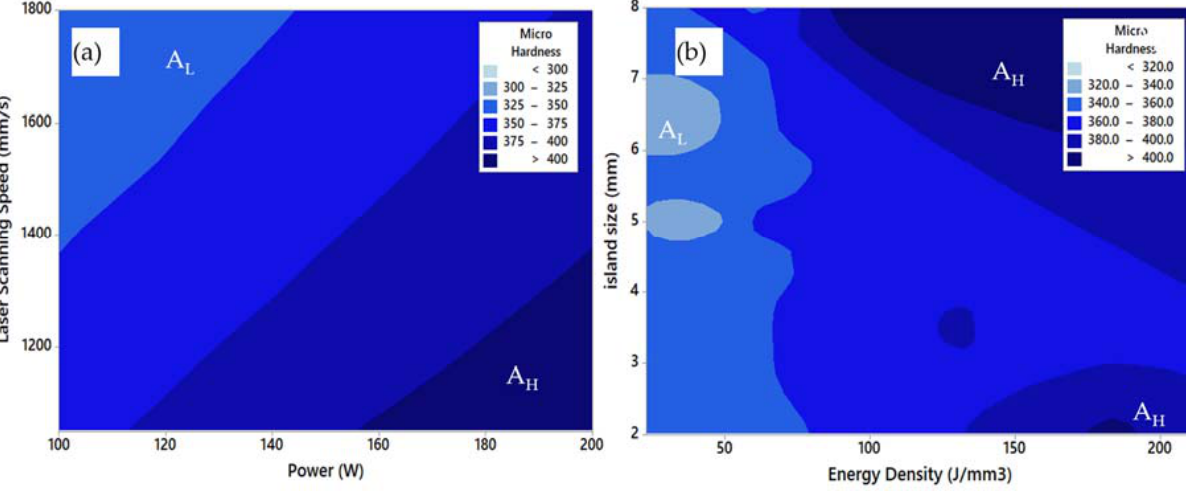
Figure 13. The predicted contours distribution of Vickers microhardness of Ti-6Al-2Sn-4Zr-6Mo alloy, ( a ) effect of power and laser scanning speed, ( b ) effect of energy density and island